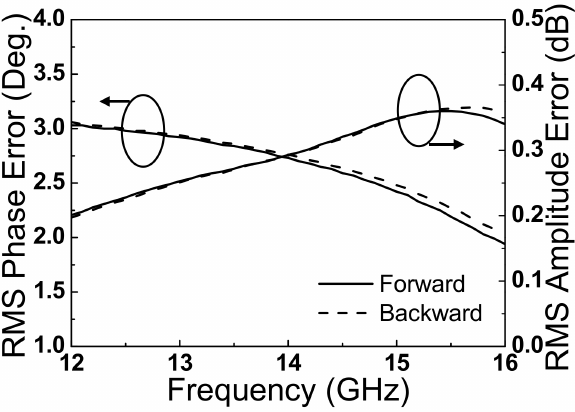
Figure 15. Measured RMS phase and amplitude errors of the attenuator.